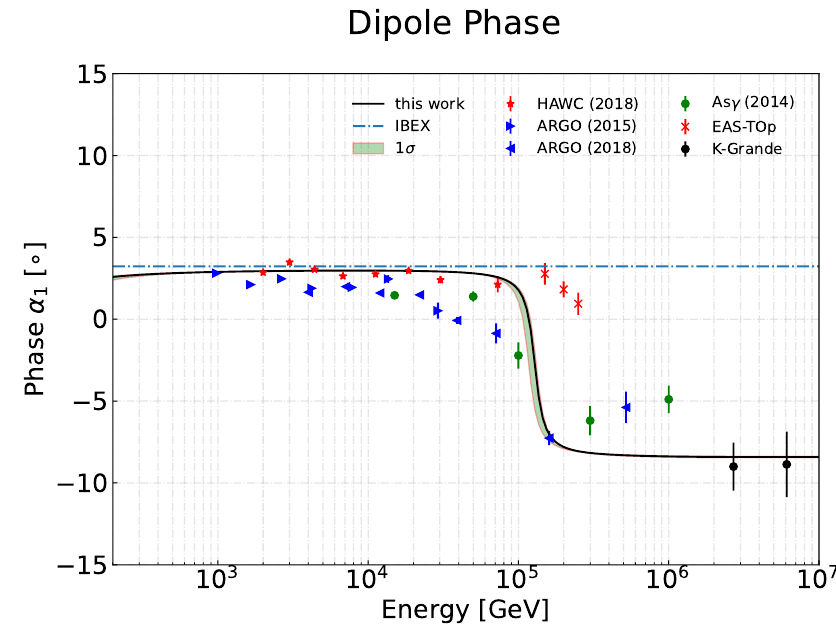
Figure 3. Amplitude and phase of dipole anisotropy fit result with best-fit parameters. The data points are taken from HAWC ([44]), ARGO-YBJ ([47,48]), and Tibet